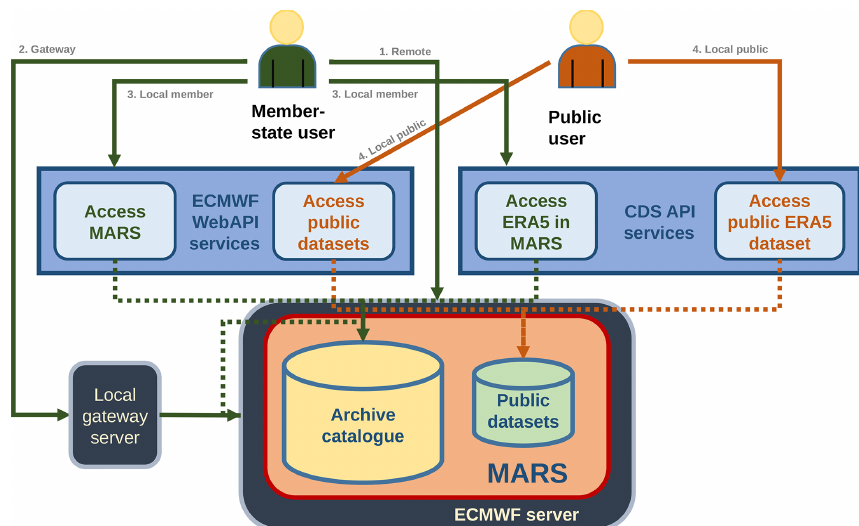
Figure 1. Schematic overview of access methods to the ECMWF MARS archive implemented in flex_extract.